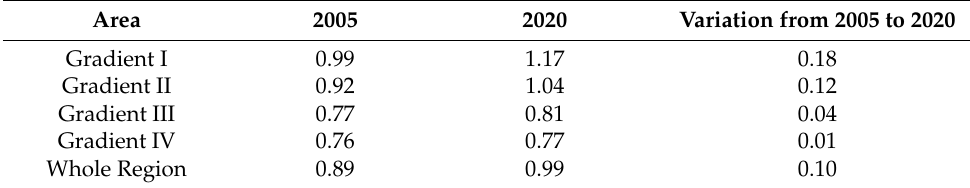
Table 5. Change of ecological risk in study area.